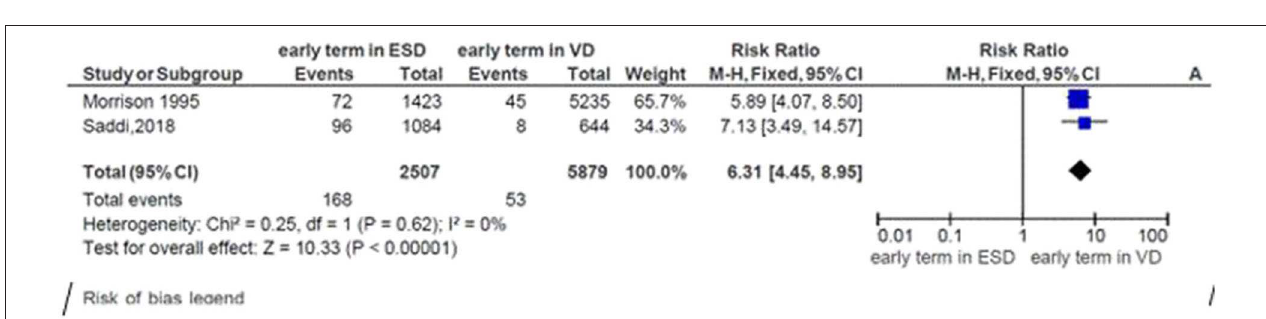
FIGURE 4 | Risk of neonatal respiratory morbidity in early term and mode of delivery, 2019.